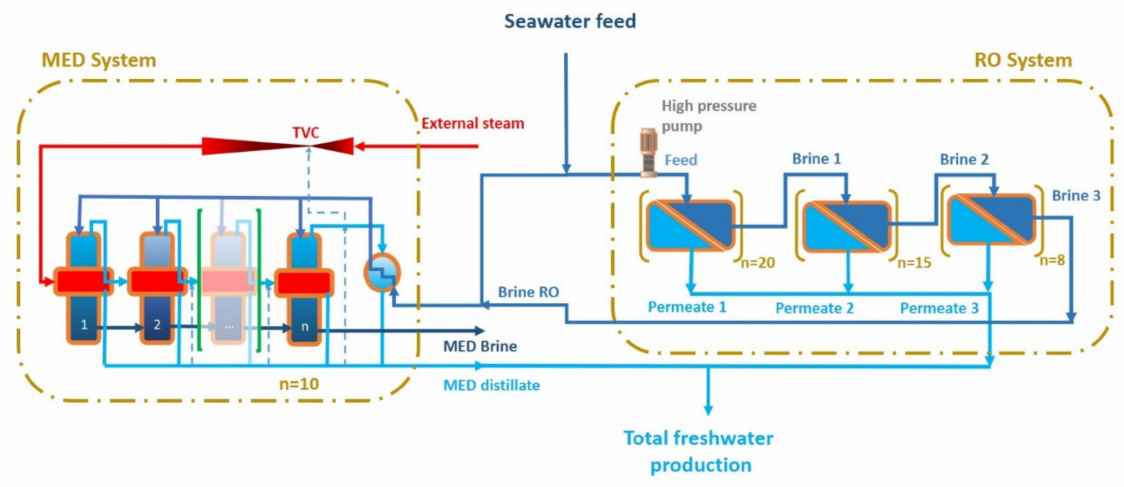
Figure 6. Diagram of RO-MED-TVC hybrid system, the RO System is upstream, proposed by Filippini et al.